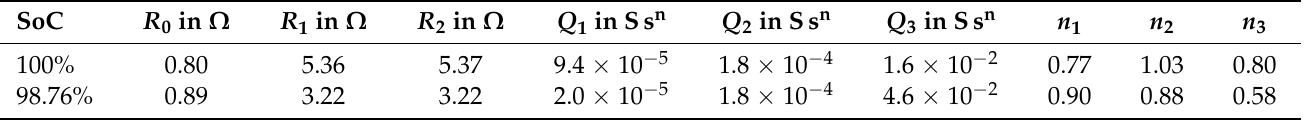
Figure A4. ZAB PR48 concatenated discharge profiles at 3 mA and various temperatures from 253 K to 313 K. The rest phases and the EIS measurements were removed from the data resulting in peak artifacts. Table A1. Fitted ECM values from the EIS measurements shown in Figure